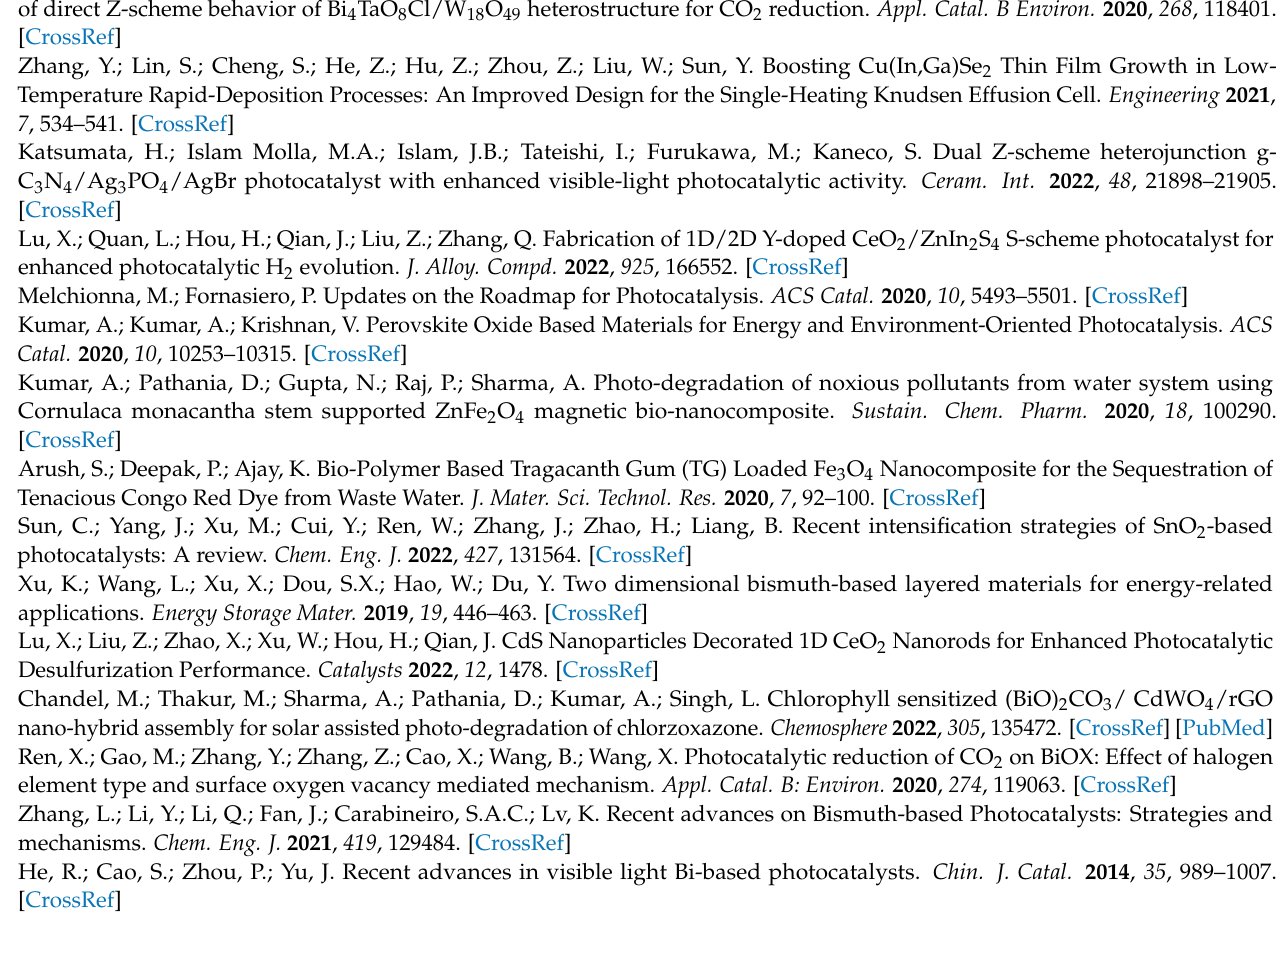
Figure S3: O 1 s XPS spectrum of the BFTO-Br sample; Figure S4: Degradation rate of MO/RhB over (a) BFTOC and (b) BFTOC with the addition of p-BQ, EDTA-2Na and TBA; Table S1: The average CO production rates of BFTOX at different